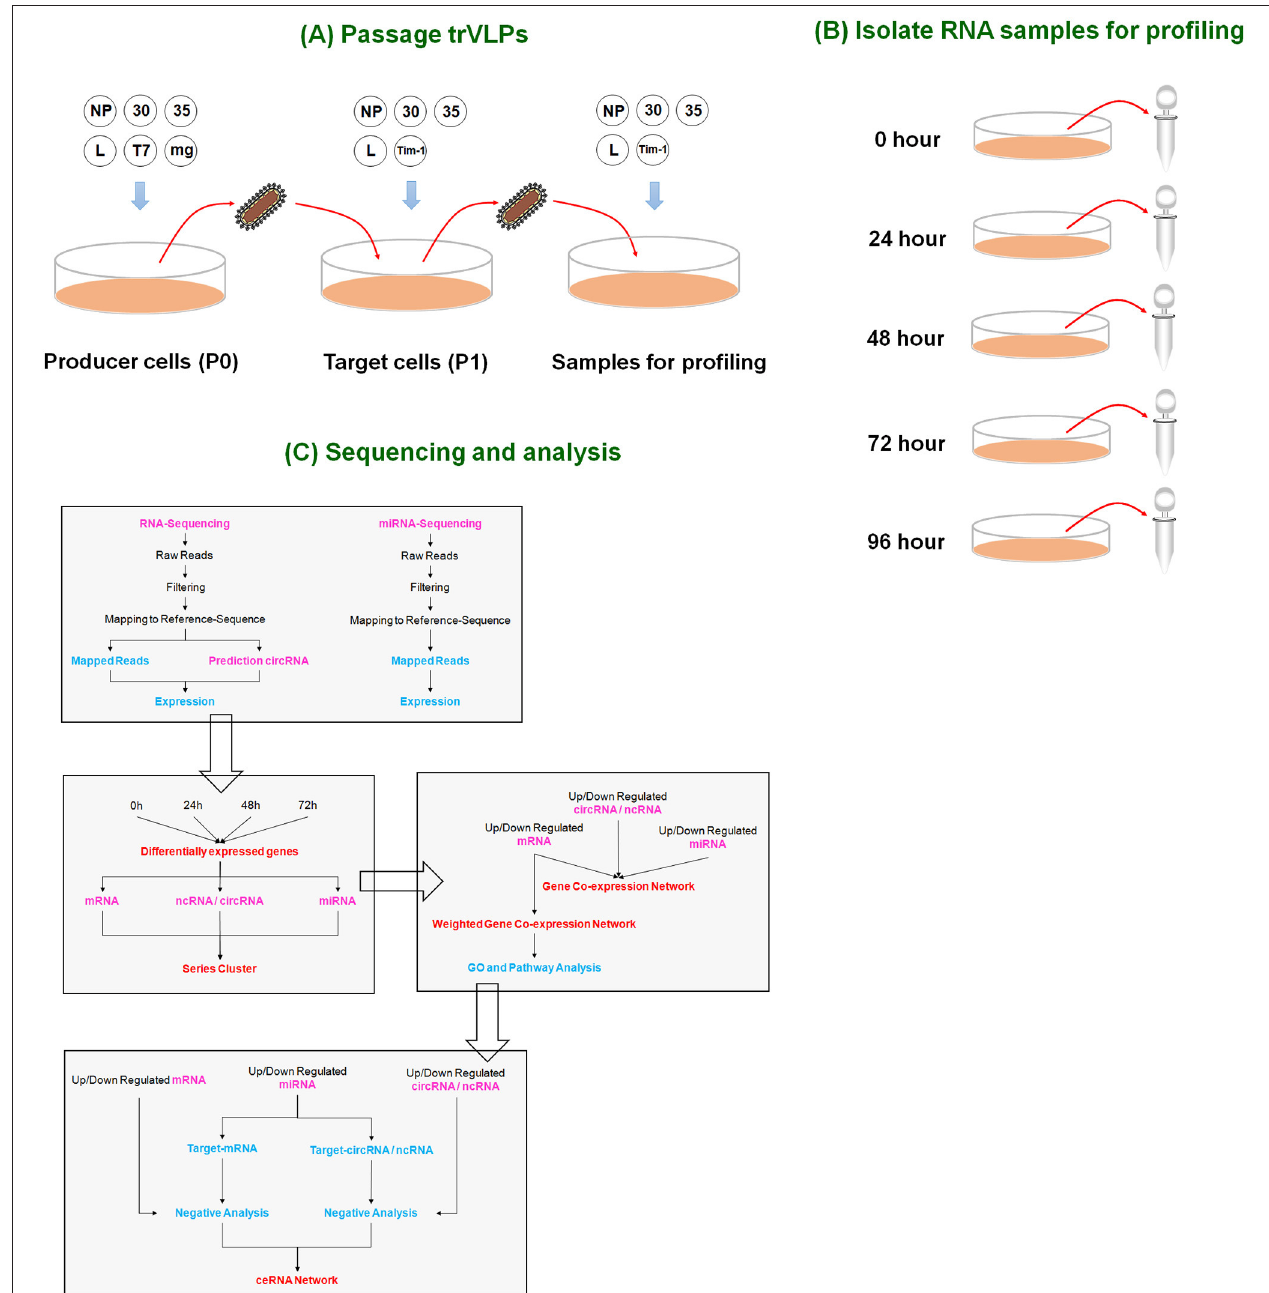
FIGURE 1 | Overview of the experimental design. (A) Passage of trVLPs. P0 trVLPs were obtained from producer cells containing plasmids (NP, 30, 35, L, T7, and minigenome). P0 trVLPs were then used to infect target cells to obtain P1 trVLPs. The P1 trVLPs were used to prepare samples for profiling. (B) Isolation of RNA samples for profiling. P1 trVLPs were used to infect target cells in a 6-well plate (2 ml/well). The P1 trVLP TCID 50 was 10 − 6.5 /ml, and there were 4 × 10 5 infected cells/well. Five time points were selected to harvest samples for sequencing based on trVLP infection and replication (see Figure 2 ). (C) Profiling and analysis. Genome-wide RNA sequencing and miRNA sequencing were performed to identify the ceRNAs responsible for the effects induced by Ebola viral infection and replication in human cells.